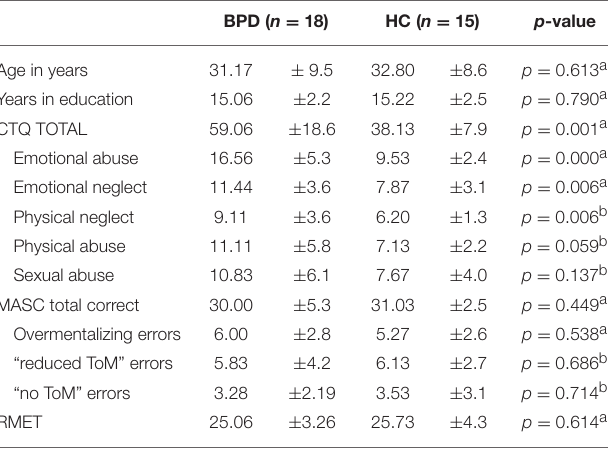
TABLE 1 | Demographic and clinical characteristics of BPD patients and healthy participants